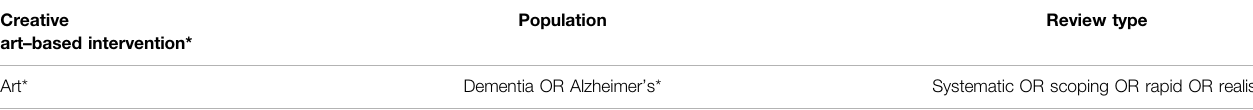
TABLE 1 | Search strategy in PubMed for creative art therapy